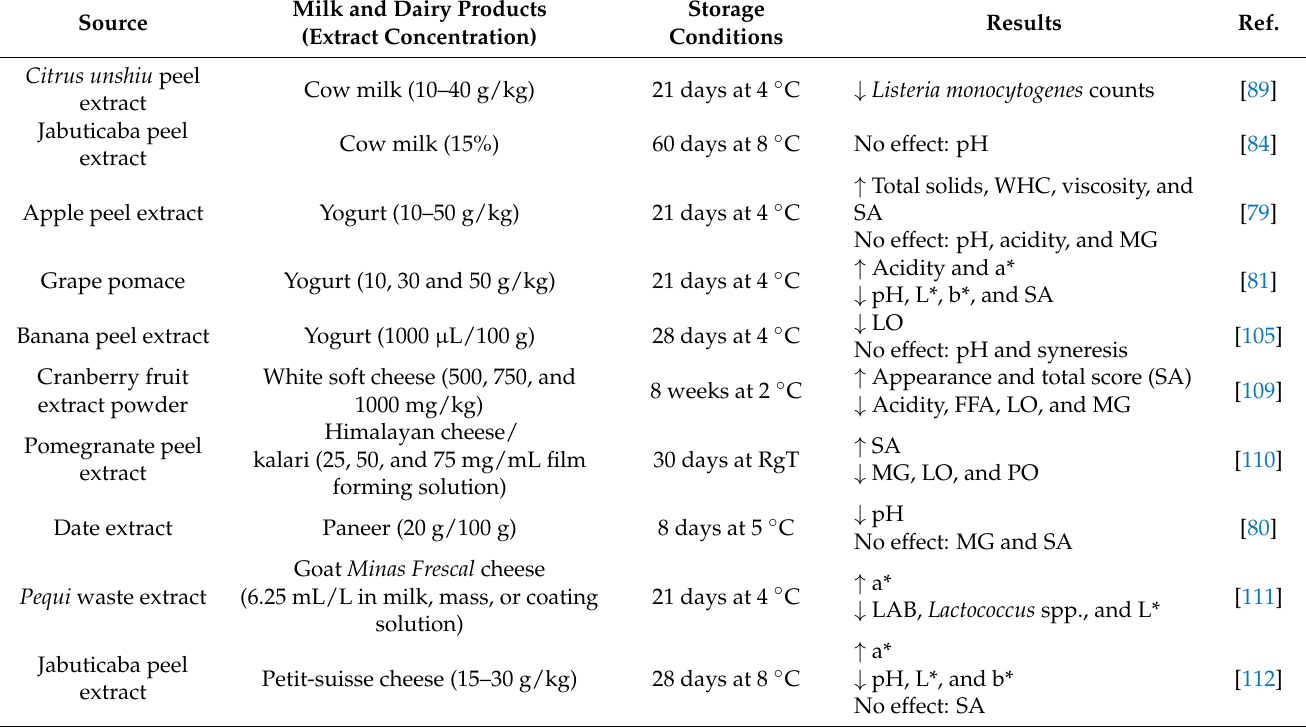
Table 6. Preservative effect of fruit bioactive compounds in milk and dairy